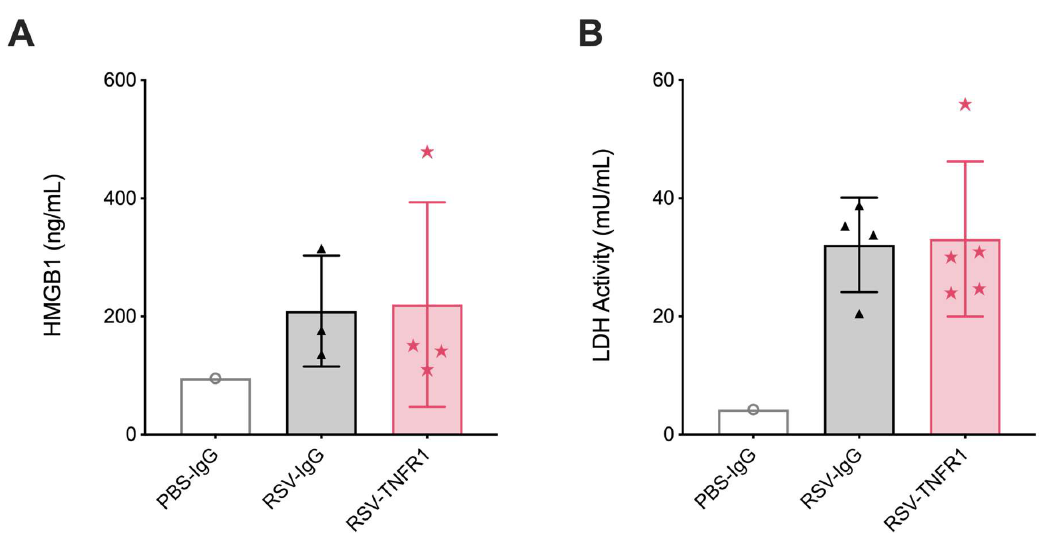
Figure10. Post-infectionblockadeofTNFR1doesnotmodulatecelldeathinRSVinfections. BALFcollected at day one p.i. was analyzed for ( A ) HMGB1 and ( B ) LDH activity. Data are expressed as mean ± SD.